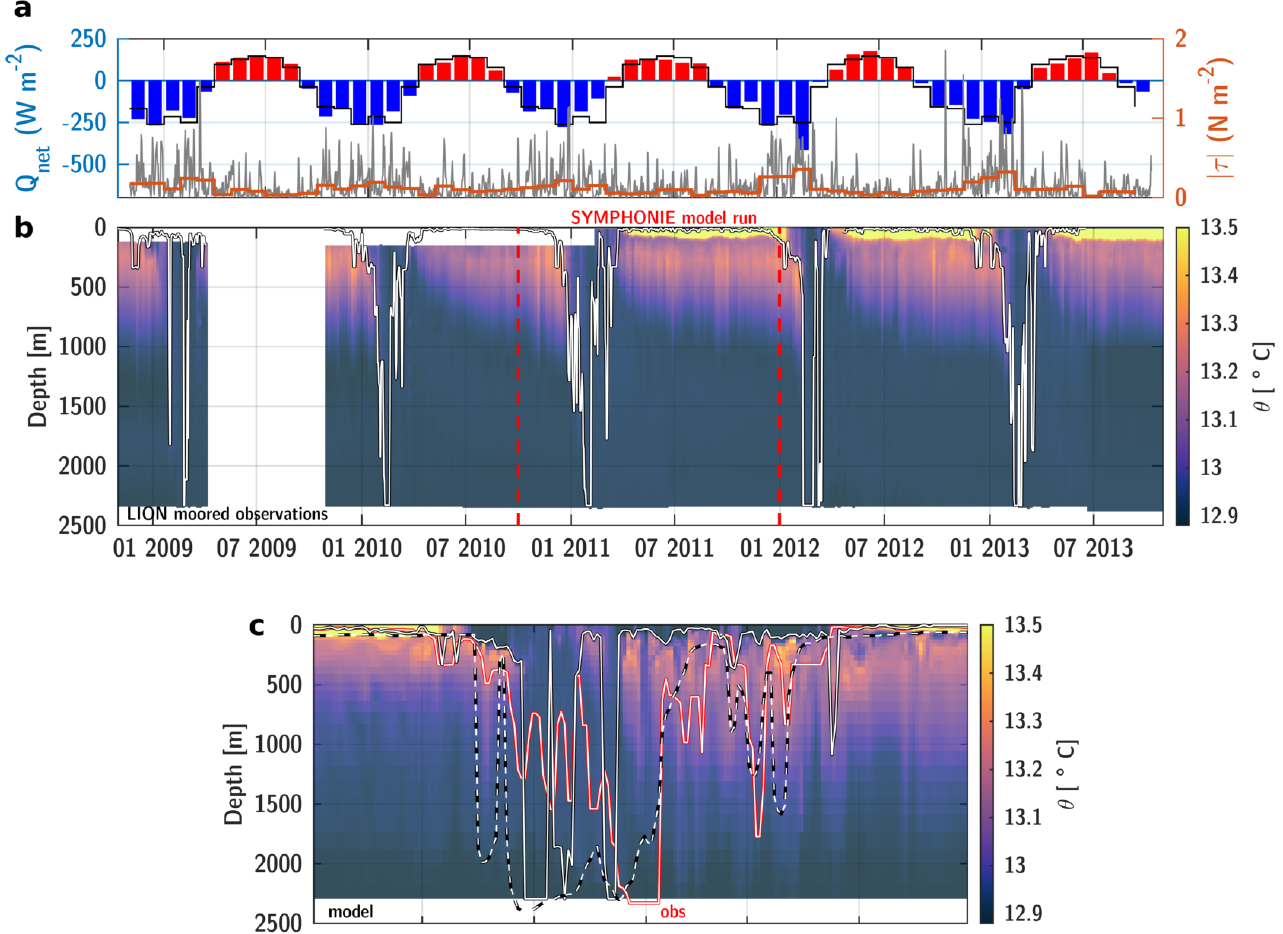
Figure 2. ( a ) Net surface heat loss (left axis) and wind stress amplitude (right axis) from CNRM-ALADIN reanalysis at the LION mooring location. Red and blue bars show monthly net heat flux with mean seasonal cycle represented by the black line. Wind stress amplitude were daily/monthly averaged in orange/gray. ( b ) Observed potential temperature at LION moored time series with MLD from [1] represented in white. The period of numerical simulation from October 2010 to December 2011 is shown in red. ( c ) Potential temperature simulated by SYMPHONIE at LION mooring site during the winter 2011. Simulated MLD at LION is shown by solid white line. MLD is here from a 0.1 ◦ C threshold criterion on temperature profile. The dashed line represents the 95th percentile of the MLD in a box 41.5–42.5 ◦ N/4–5 ◦ E around the mooring position representative of the deep convection area. Observed MLD is shown in red as